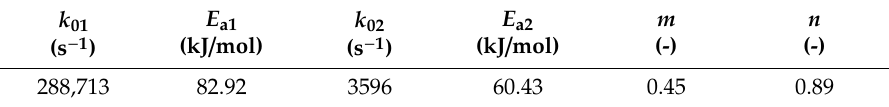
Figure 7. (a ) 3D plot of the reaction rate d α /dt at 1 °C/min as a function of the temperature and the degree of reaction α ; ( b ) comparison of experimental reaction rate and Equation (8) predictions. Table 2. Kinetic parameters for the PRISM EP 2400 resin.